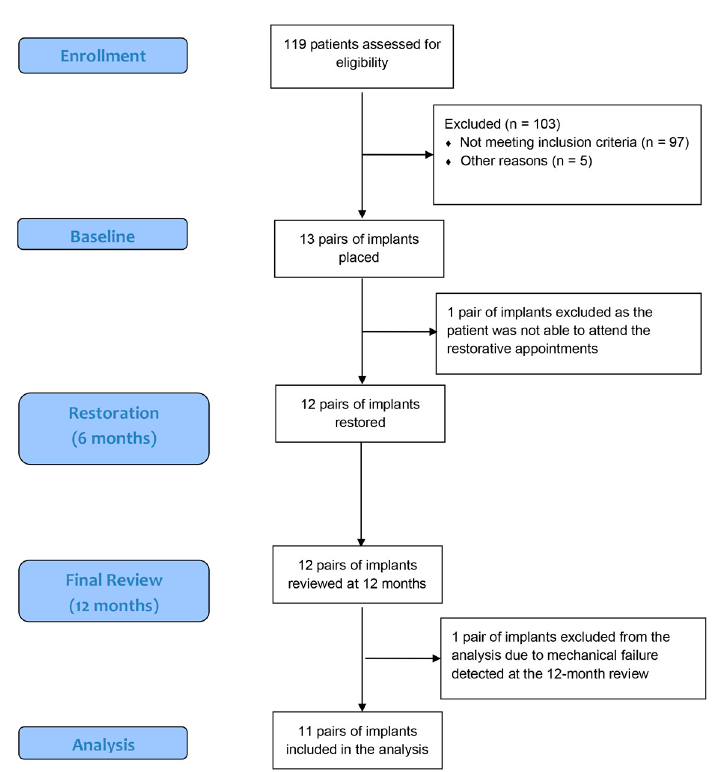
Figure 2. Consort Flow Diagram. Table 1. Patient demographics, site and size of the